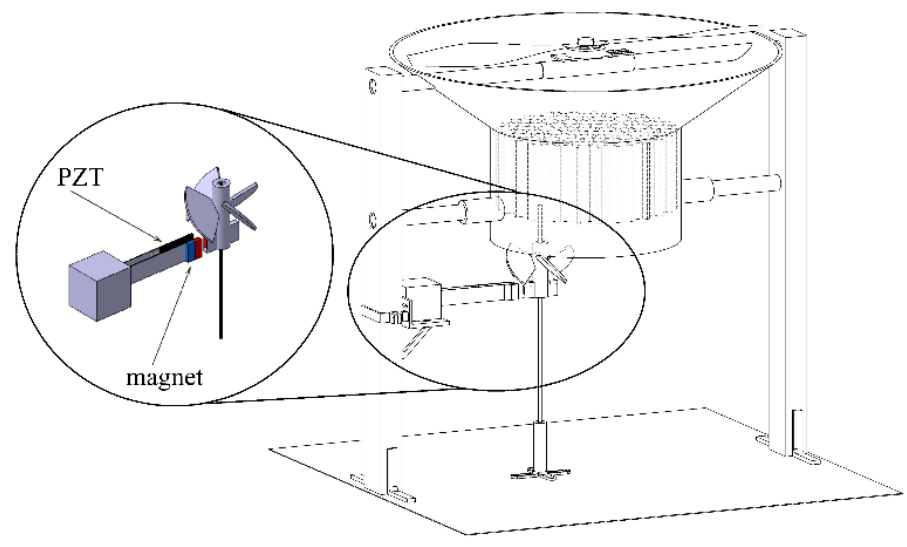
Figure 1. Concept of the wind driven magneto electric vibration energy harvesting system.